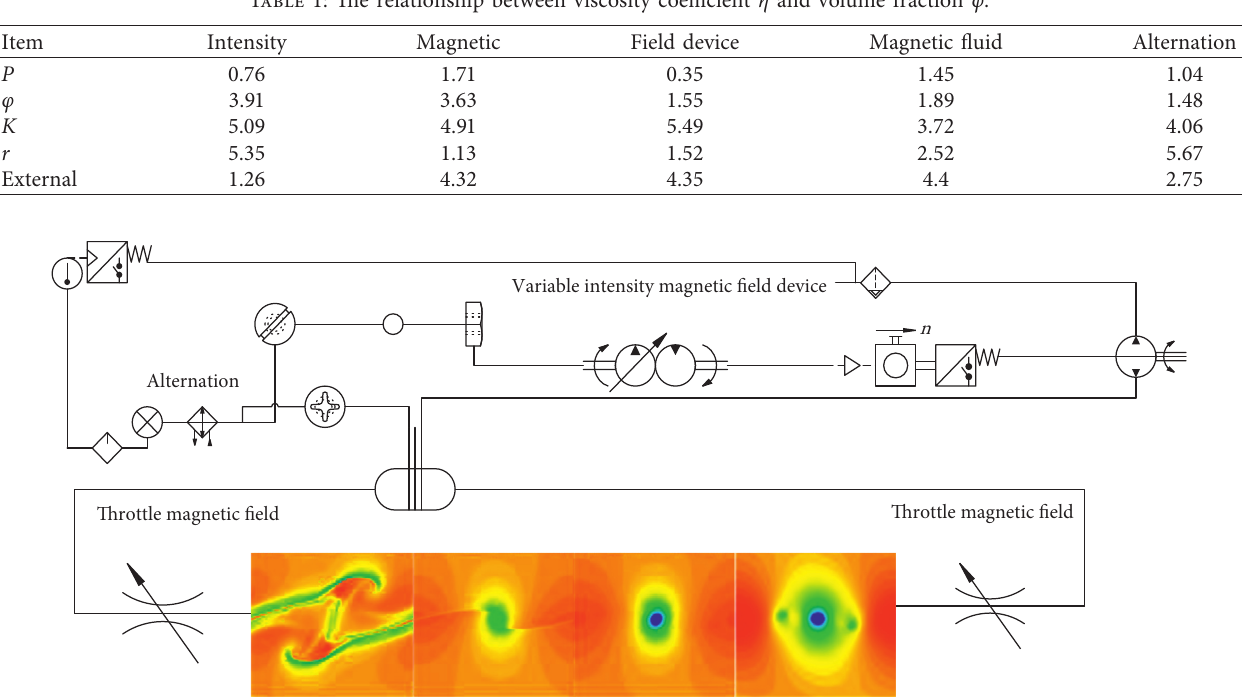
Figure 4: Dependence of actual heating power on